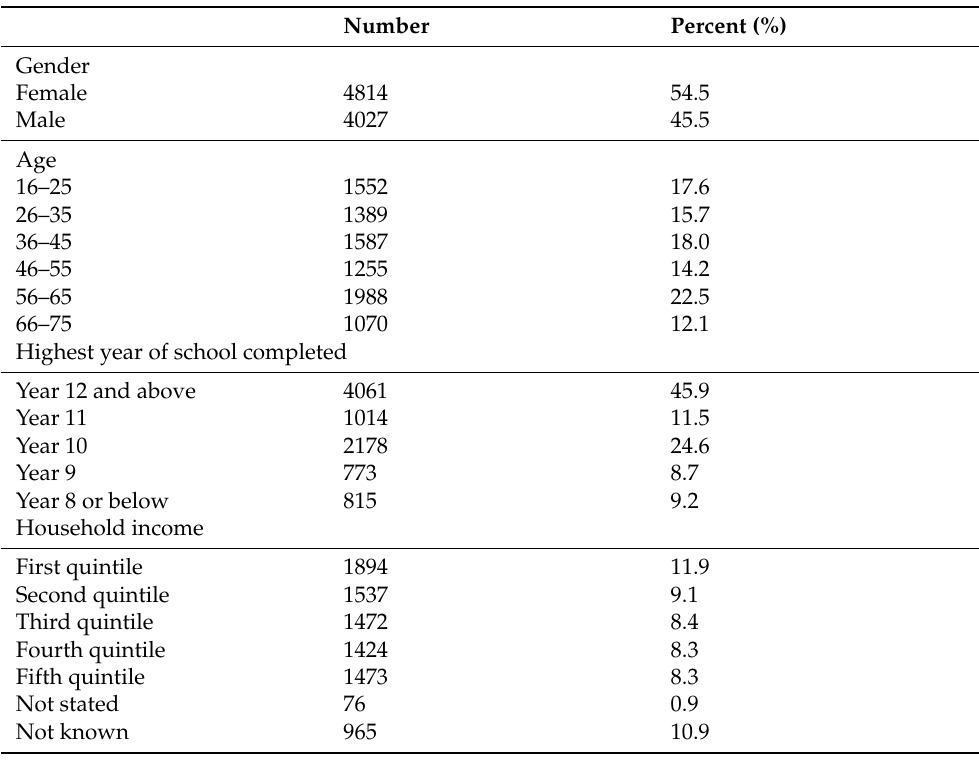
Table 1. Distribution of selected sociodemographic factors in the 2007